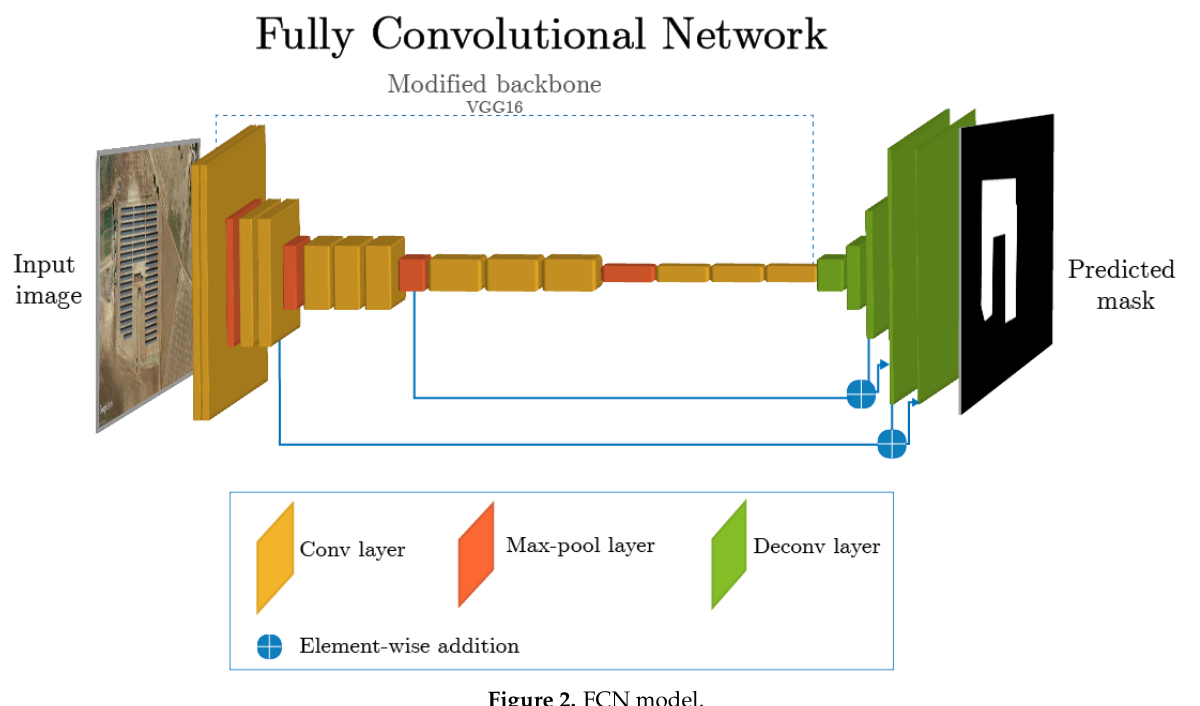
Figure 2. FCN model.